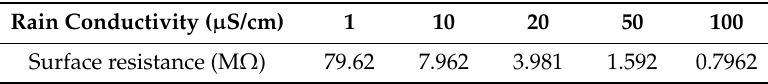
Table 6. Surface resistance of sample under different rain conductivities.